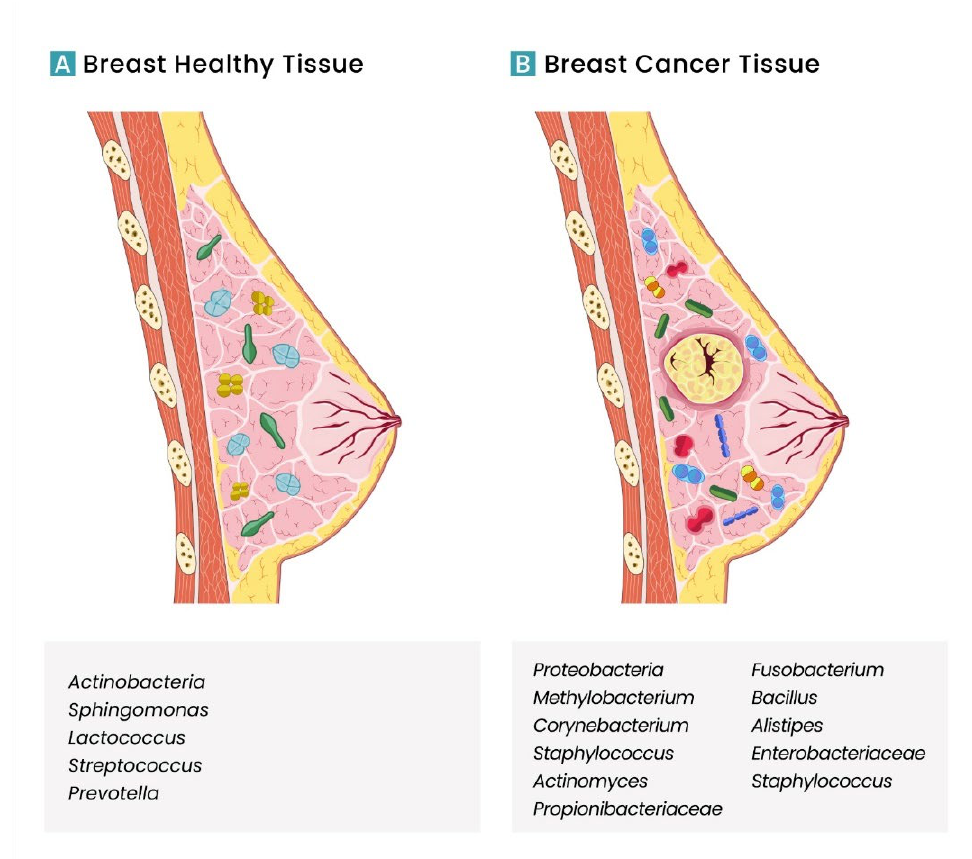
Figure 2. Different microbiota profiles in breast tissues according to different studies. ( A ) Breast healthy tissue; ( B ) breast cancer tissue.